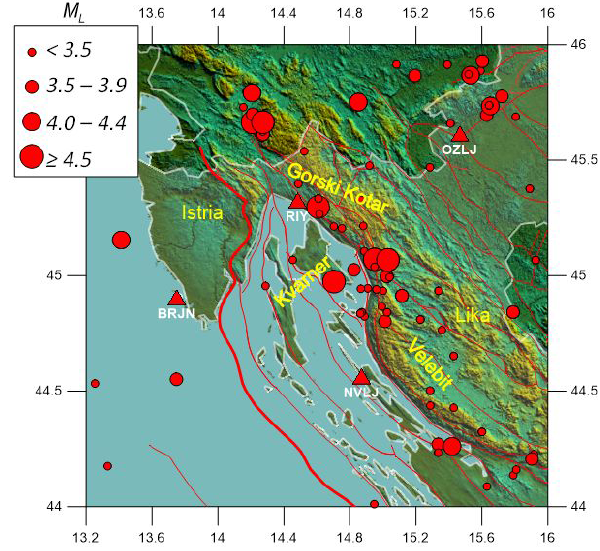
Figure 2. Topographic map of the study area with earthquake epi- centres (2002–2016) used for κ calculation. Red triangles mark the locations of seismic stations. Red lines represent possible seismo- genic surface faults in Croatia (Ivanˇci´c et al., 2006). The thick red line designates frontal Dinaridic structures as well as the boundary between the External Dinarides and the Adriatic foreland. When preparing figure, Copernicus land dataset was used (© European Union, Copernicus Land Monitoring Service 2017, European Envi- ronment Agency –